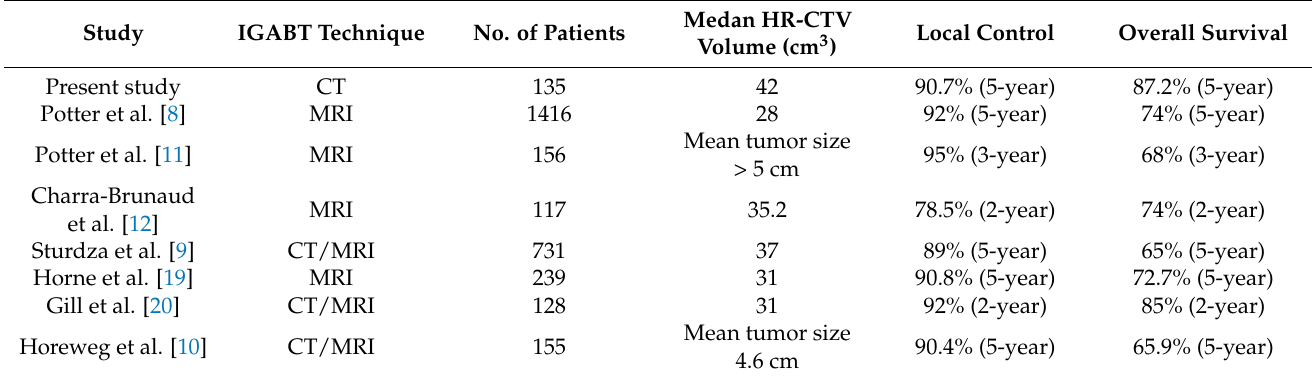
Table 4. Comparison to other studies on IGABT for cervical